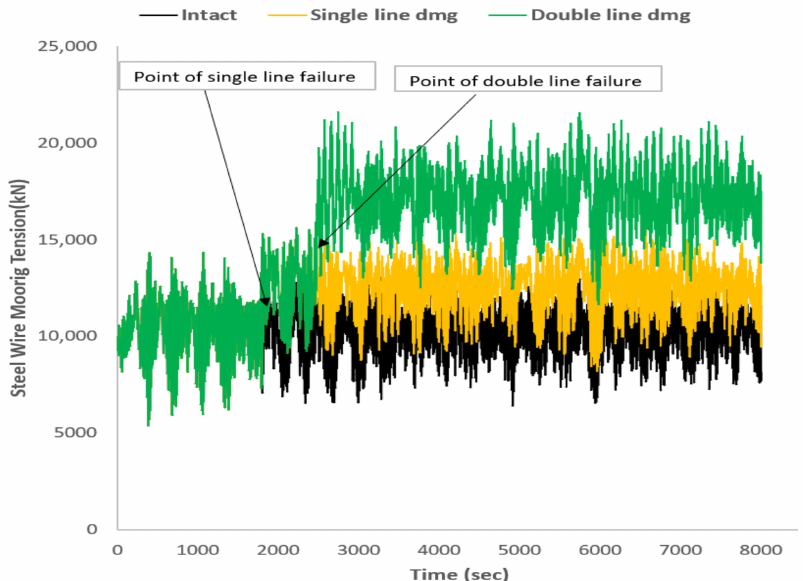
Figure 14. Comparison of steel wire representative mooring line (line 12) in intact and damaged